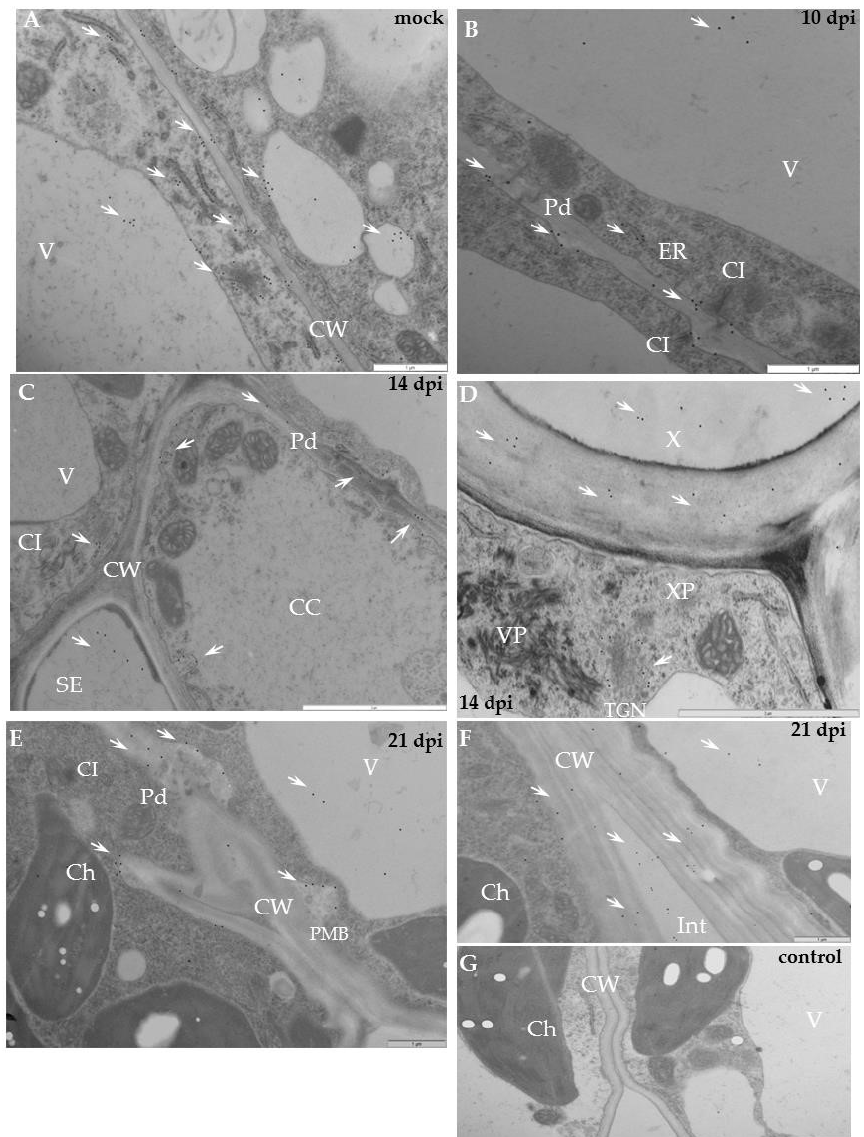
Figure 9. Immunogold labelling of xyloglucan xyloglucosyl-transferase (XTH-Xet5) during potato–PVY NTN compatible interaction. ( A ) Gold granules (arrows) of XTH-Xet5 deposition are visible in cell wall, vacuoles as well as around ER and trans-Golgi network in mesophyll cells of mock-inoculated potato Irys leaf. Bar 1 µm ( B ) XTH-Xet5 deposition (arrows) in cell wall, around plasmodesmata and in vacuole. Virus cytoplasmic inclusions next to plasmodesmata 10 days post-inoculation. Bar 1 µm ( C ) XTH-Xet5 localisation (arrows) in sieve element, also in cell wall next to plasmodesmata in phloem parenchyma 14 days post-virus inoculation. Bar 2 µm. ( D ) XTH-Xet5 (arrows) in xylem tracheary element and around the trans-Golgi network. Viral particles are noticeable in xylem parenchyma cell. Bar 2 µm. ( E ) XTH-Xet5 depositions (arrows) are in loosened cell wall, around plasmodesmata and in vacuole. Plasma membrane retraction from cell wall with paramular bodies. Virus inclusions are in cytoplasm 21 days post-virus inoculation. Bar 1 µm. ( F ) XTH-Xet5 deposition (arrows) in cell wall and in intercellular space 21 days post-virus inoculation. Bar 1 µm. ( G ) Lack of gold deposition for potato Irys–PVY NTN compatible interaction when primary antibodies were omitted (control). Bar 2 µm. CC—companion cell, Ch—chloroplast, CI—cytoplasmic inclusions, CW—cell wall, Pd—plasmodesmata, SE—sieve element, TGN—trans-Golgi network, V—vacuole, VP—virus particles, X—xylem, XP—xylem parenchyma.